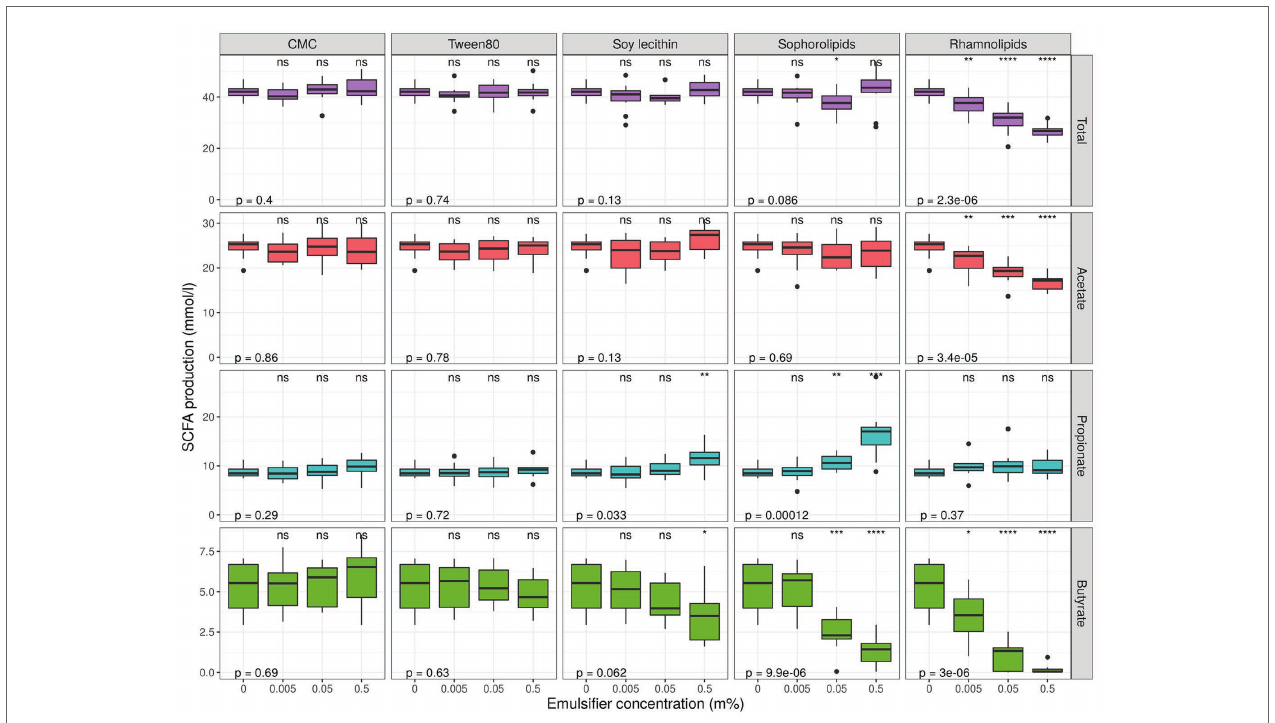
FIGURE 7 | Short chain fatty acid production levels over 48 h of incubation of fecal material from 10 donors in sugar depleted medium supplemented with five emulsifiers at four concentrations. Samples were taken upon incubation (T0; 2–3 h after inoculation) as well as after 24 h (T1) and 48 h (T2) of incubation. Asterisks indicate significant differences with the control [0% (m/v)], calculated with Wilcoxon Rank Sum tests with Holm’s correction. p -values indicate results of general Kruskal–Wallis tests ( α =